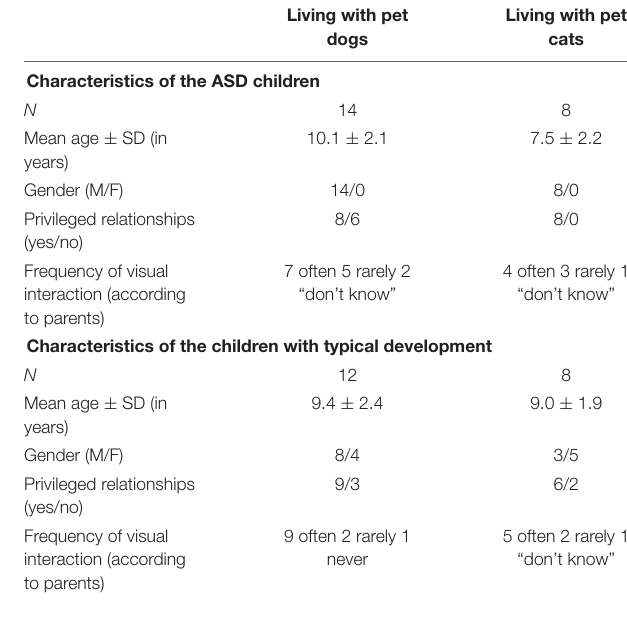
Living with pet Living with pet dogs